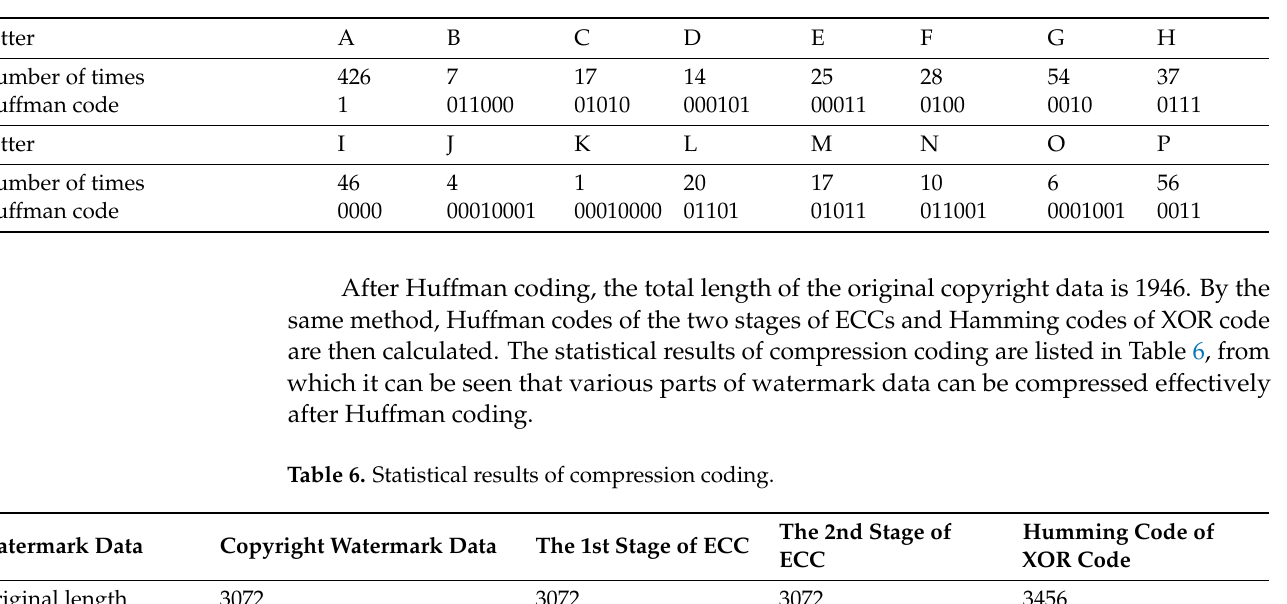
Table 5. Results of Huffman coding taking the original copyright watermark data as an example.